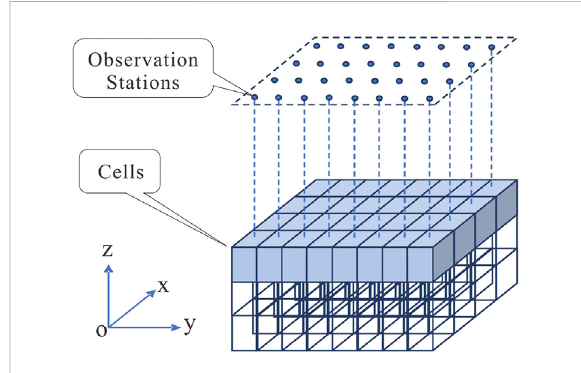
FIGURE 2 Fracture model and the horizontal gradient diagram. (A) Density model of fracture. (B) Horizontal gradient model of fracture